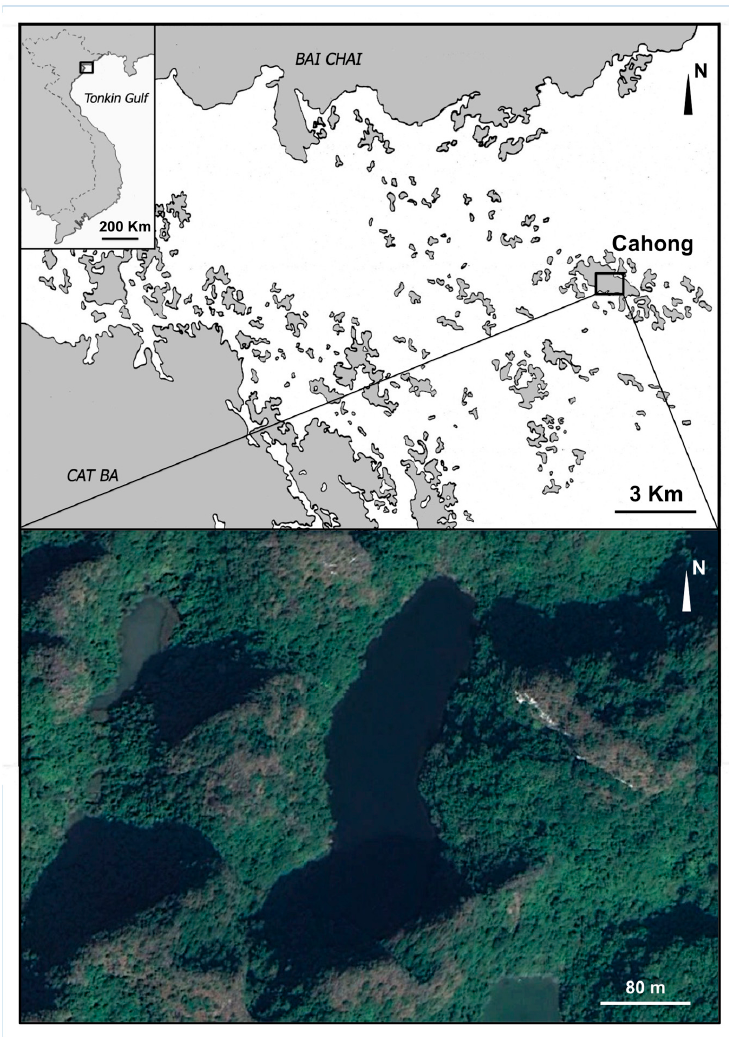
Figure 1. Map of the sampling site. The image below illustrates the Cahong lake.